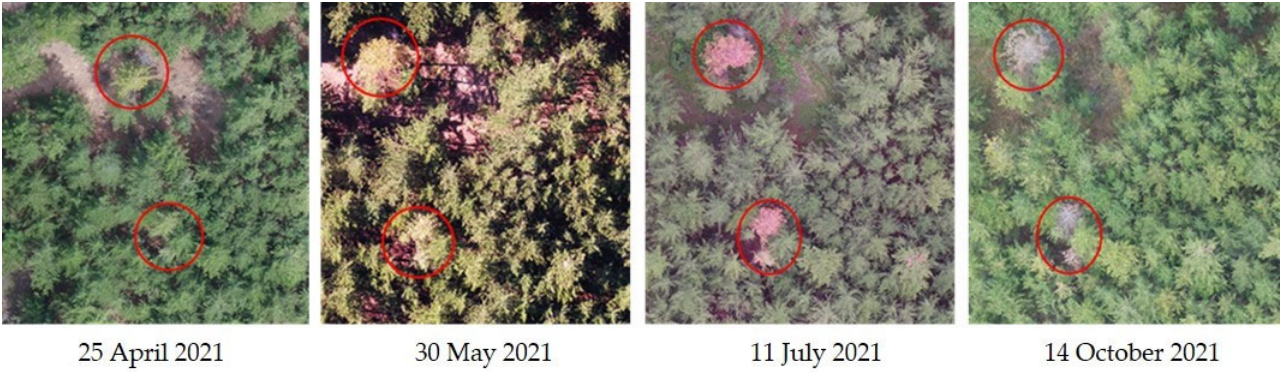
Figure 1. Crown color change of infested trees in UAV images. The red circles indicate pine trees infested by D.valens .